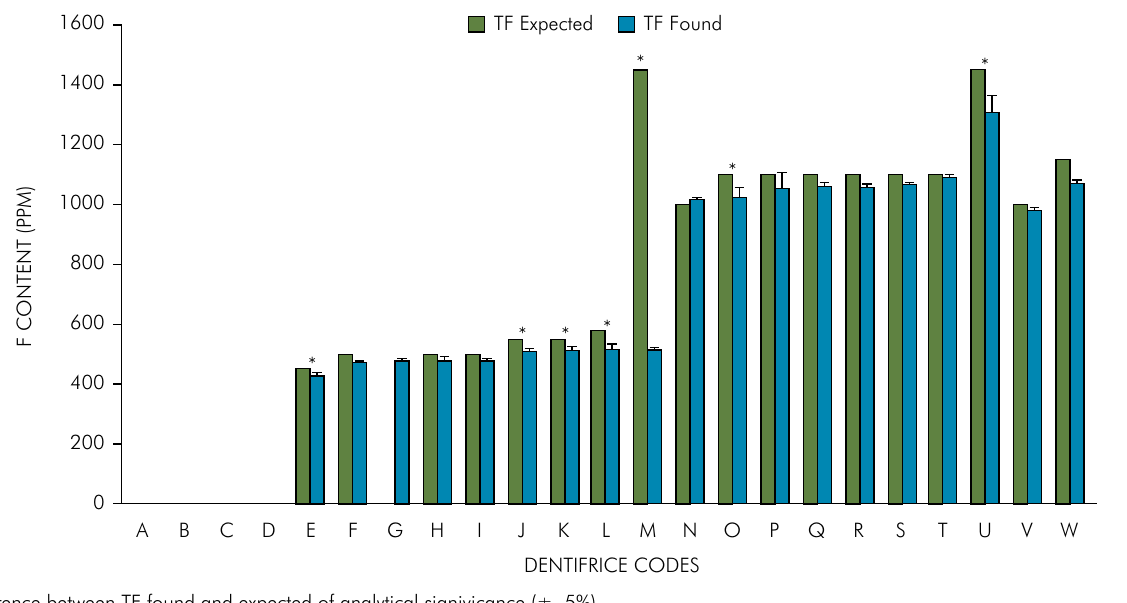
Figure 2. Concentration (ppm F) of total fluoride declared by the manufacturer (TF expected) and found in the toothpastes analyzed (TF found)